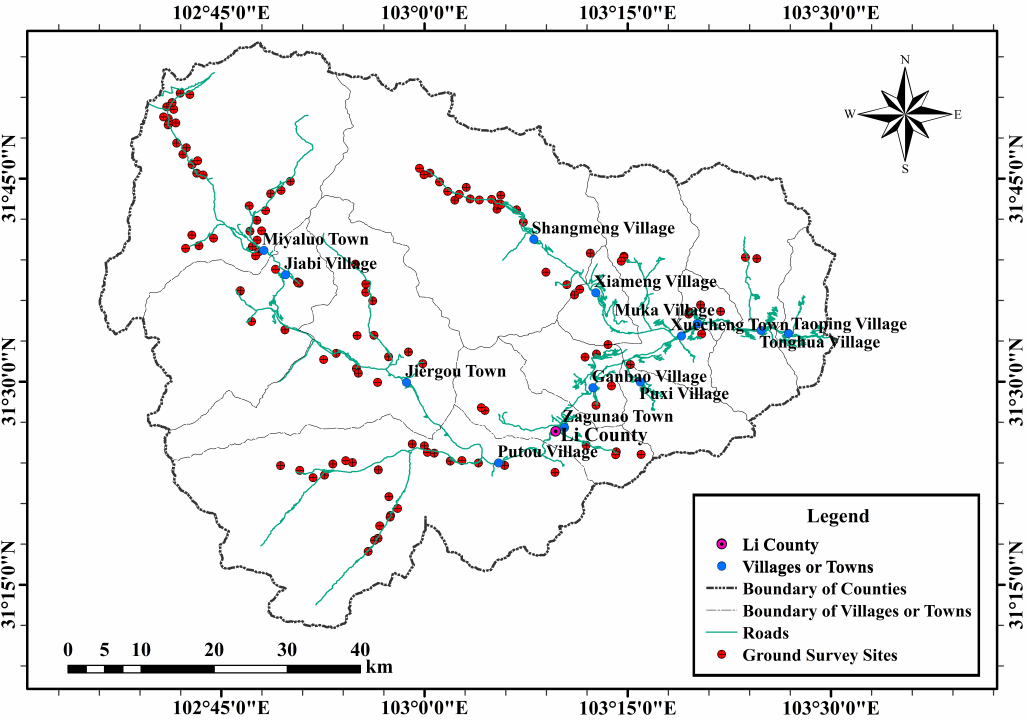
Figure 3. The ground survey site distribution in Li County. The dots (points) represent the locations of county, village or town